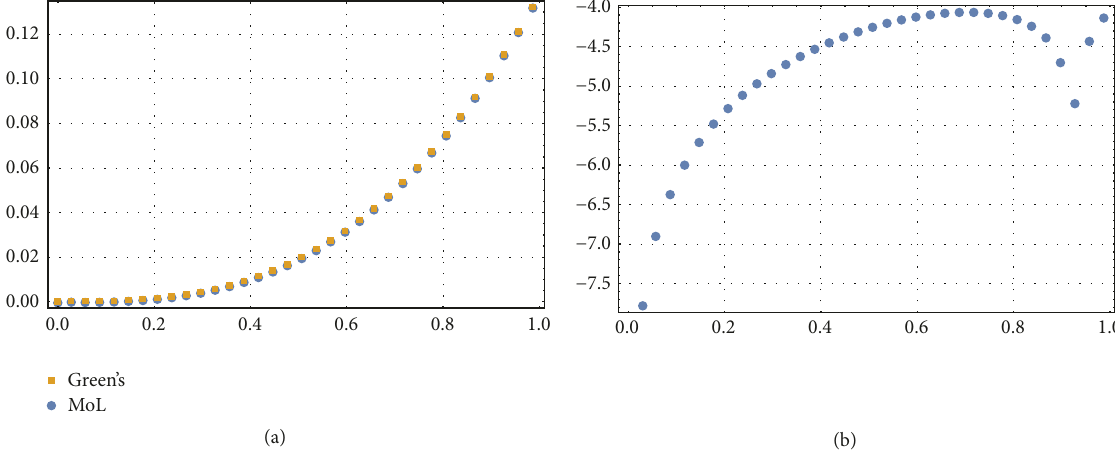
Figure 6: Discrete plot of 𝑤 and 𝑤 MoL (a) and Er (b) against 𝑡 ∈ [0, 1] for 𝑓(𝑡) = ln (1 + 𝑡) : quadratic Green’s